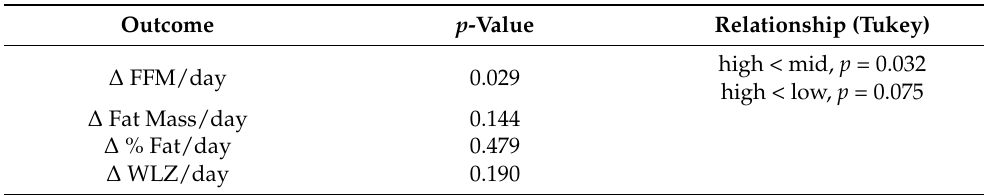
Table 3. One-way ANOVA test for infant lean and fat mass accumulation when grouped by tertiles of infant RBC AA/DHA fatty acid